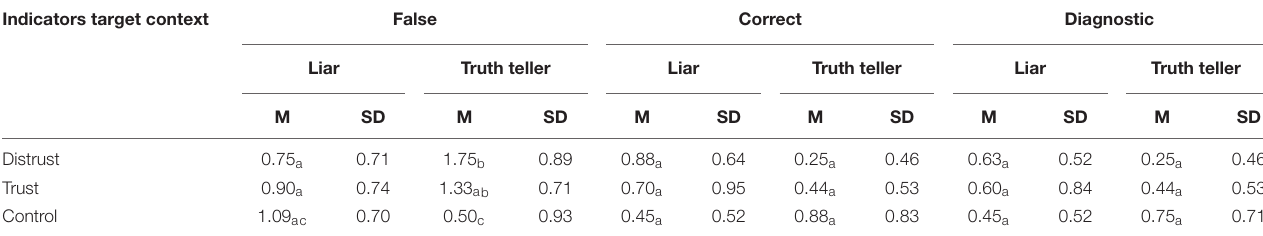
TABLE 3 | Means and standard deviations of participants’ number of mentioned false, correct, and unrelated indicators of lying, as a function of context and target for Study 2. Indicators target